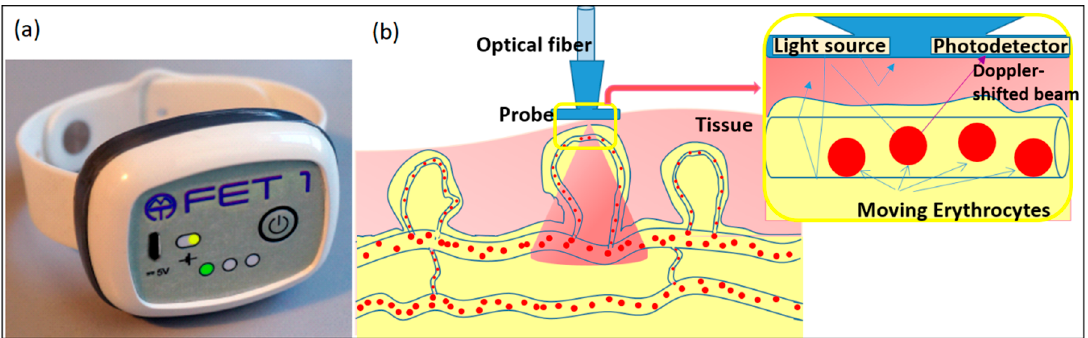
Figure 1. ( a ) Laser Doppler flowmetry (LDF) based wearable device, ( b ) schematic of the principle of LDF technique.